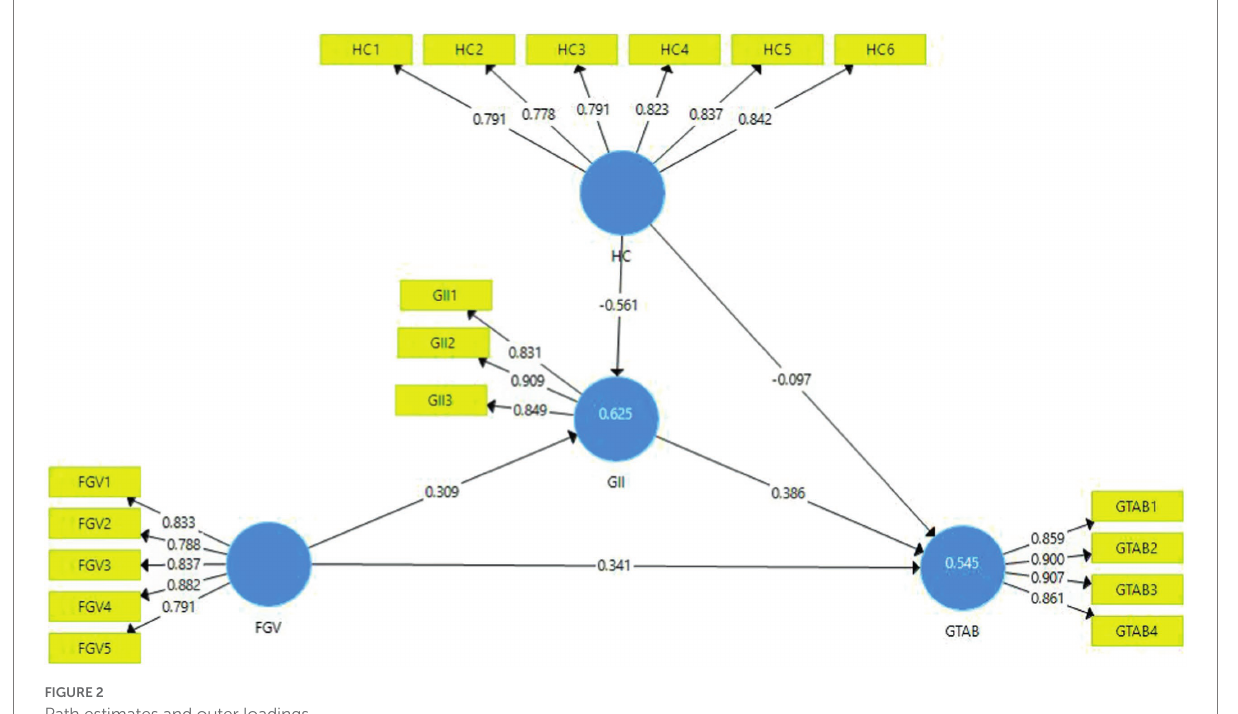
FIGURE 2 Path estimates and outer loadings.